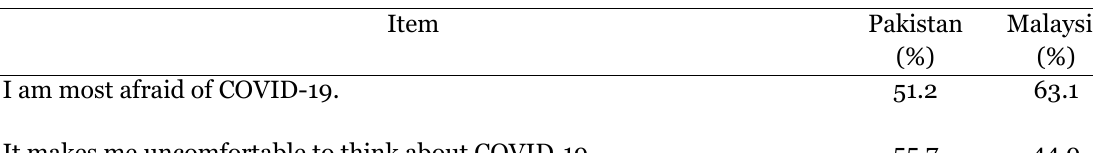
Analysis of Fear of COVID-19 Experienced by University Students of Pakistan and Malaysia